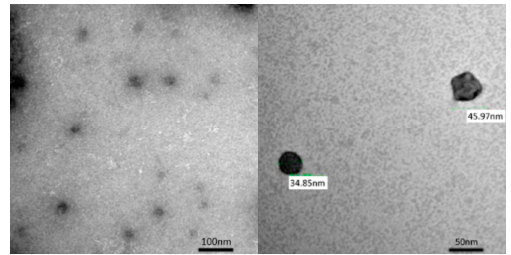
Figure 1. The size of the PAMAM-coated silica nanoparticles, PCSNs prepared was evaluated using a transmission electron microscope (TEM). The PCSN size was approximately 40 nm (between 35 nm and 46 nm).